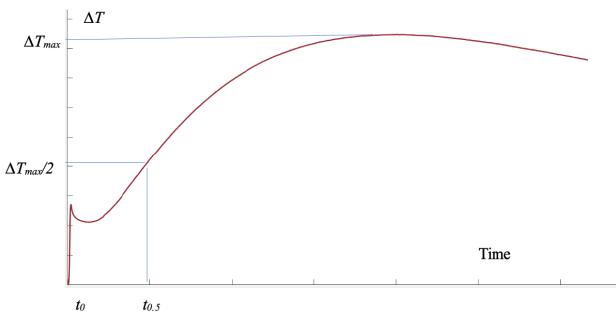
Figure 2. Transient temperature curve of a specimen after light pulse heating [17].